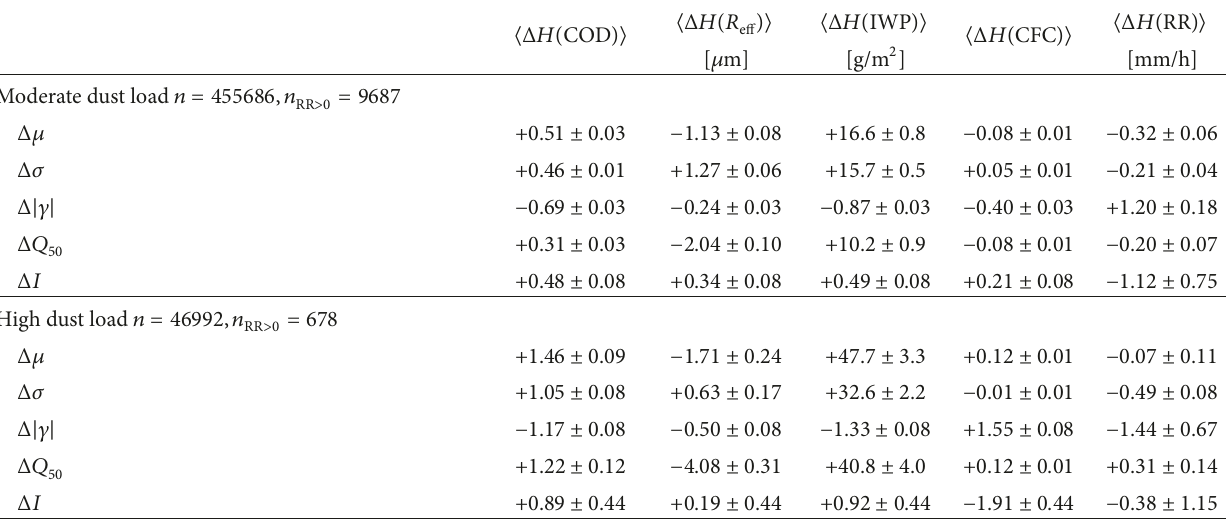
Table 1: Deviation statistics for four cloud variables COD, 𝑅 eff , IWP, and CFC and for RR for moderate and high dust loading subsets. Here, CTT has been used to describe the meteorological state.